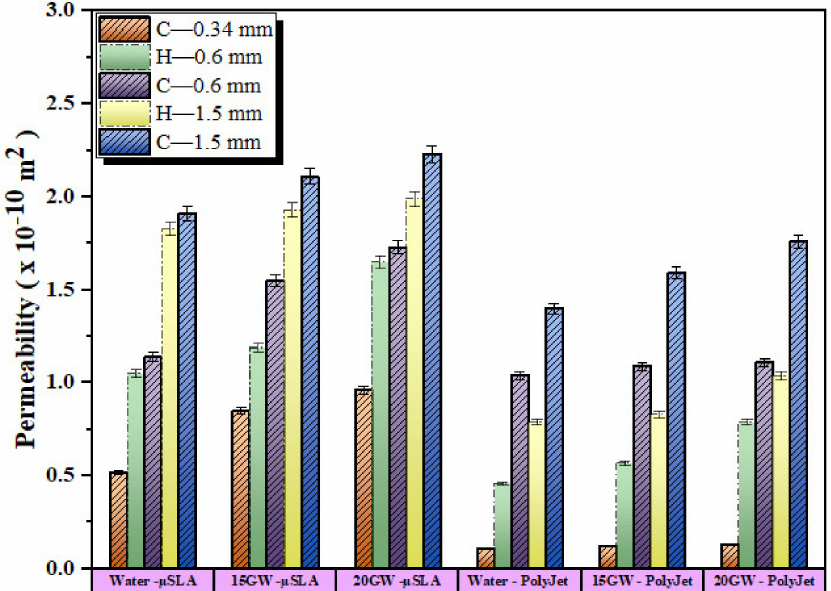
Figure 9. Experimentally measured permeability values for 3D-printed scaffold structures with cubic and hexagonal pore shapes using tap water, 15% glycerol–water solution, and 20% glycerol–water solution at 30% porosity.